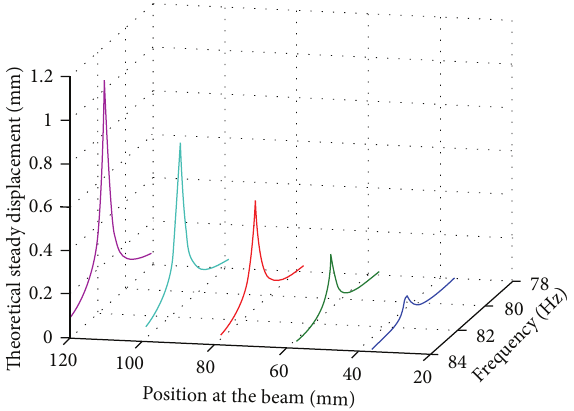
Figure 14: Theoretical steady-displacement responses versus posi- tions and frequencies with mode 𝑈 (2) 1 (𝑥) .